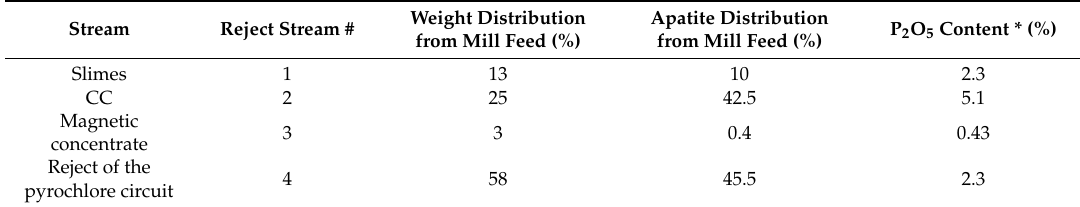
Table 1. Characteristics of the reject streams from the Niobec concentrator [11,12]. Stream